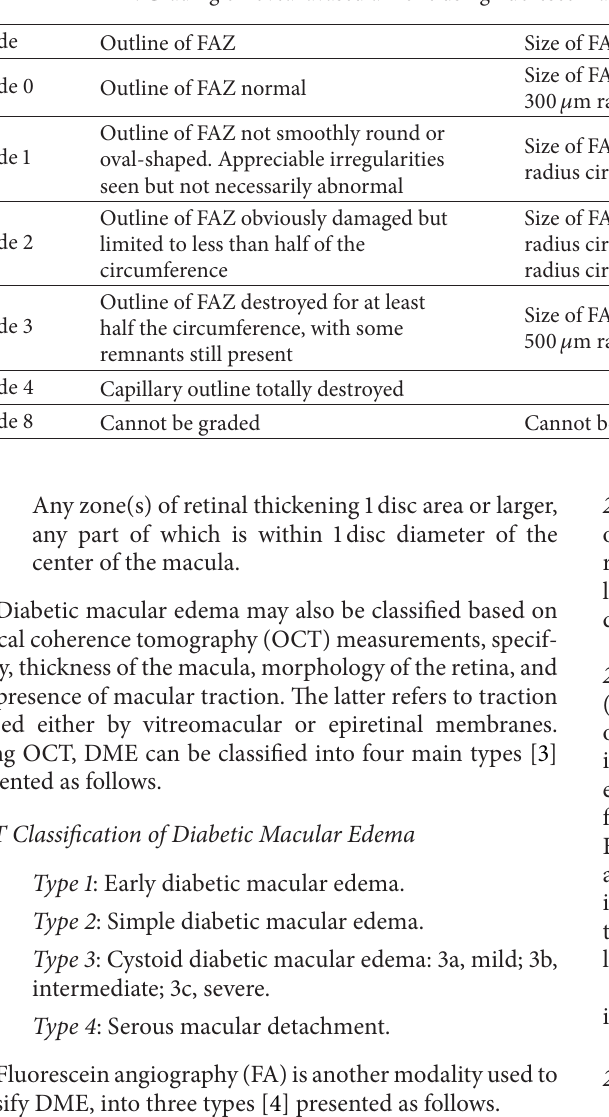
Table 1: Grading of foveal avascular zone using fluorescein angiography. * As defined in the ETDRS group report